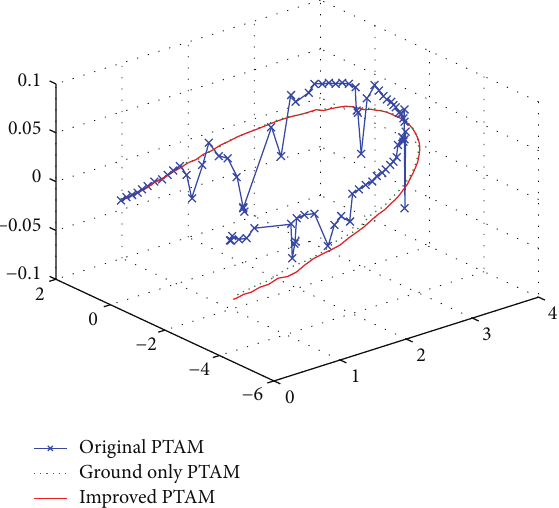
Figure 9: The estimated trajectories of mobile